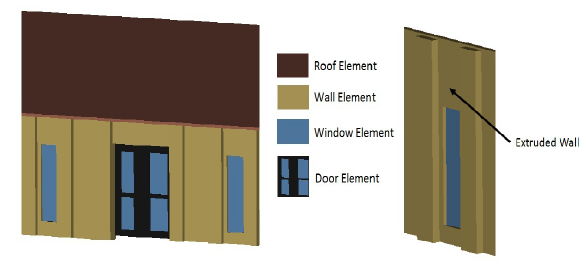
Figure 2: Example for the terminal symbols of buildings - roof el- ement, wall element, window element and door element. Extrud- ed wall that includes inset window structure and stick-out wall parts is shown on the right hand side.